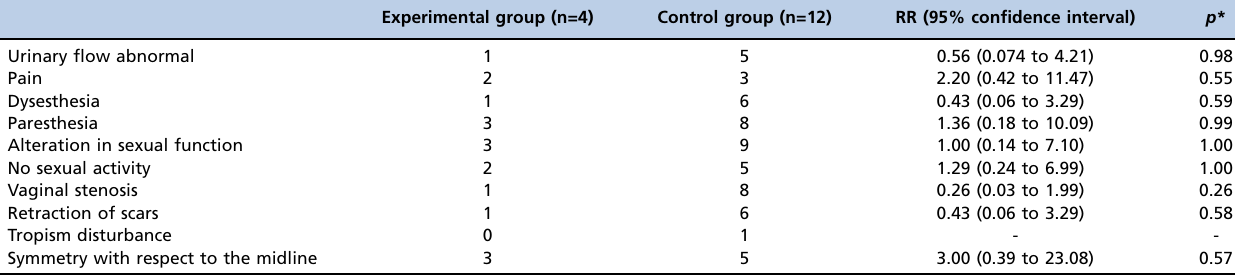
Table 2 - Functional results after surgical